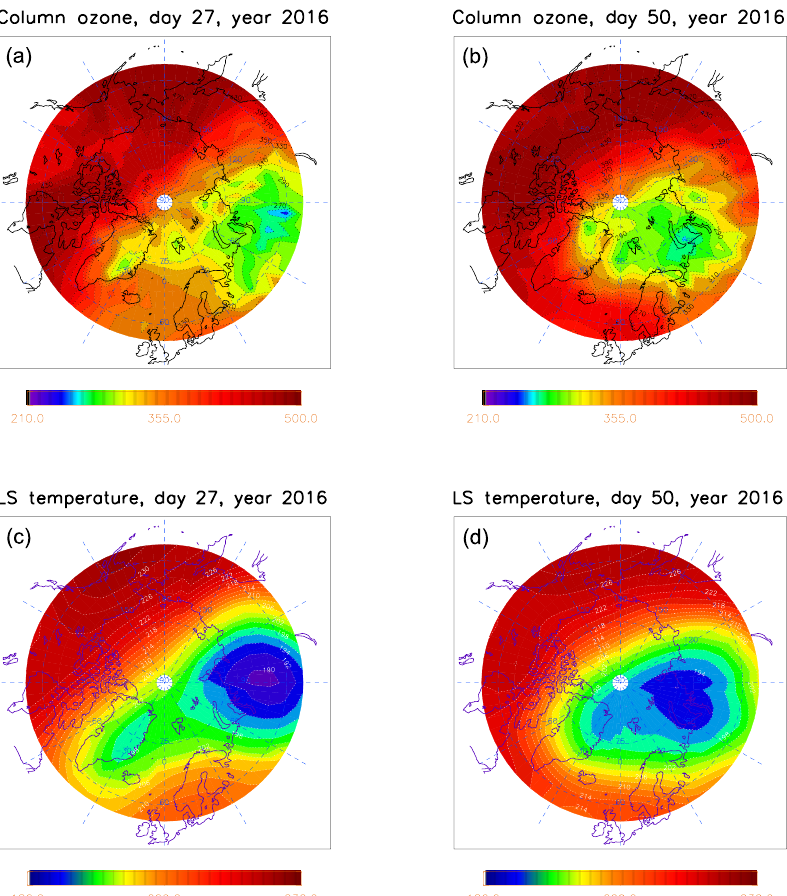
Figure 4. Column ozone (DU) for the days with minimum local registered values (27 January, a, c , and 19 February, b, d ), simulated with the RSHU model (a, b) and temperature of the lower stratosphere (K) from MERRA reanalysis (c, d)